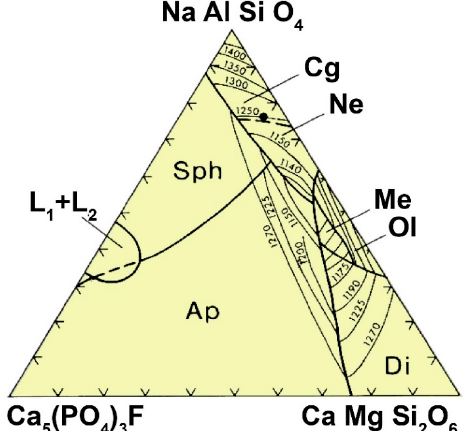
Figure 7. Phase relations in the system NaAlSiO 4 —CaMgSi 2 О 6 -Ca 5 (PO 4 ) 3 F at 1 atm. pressure [9]. С g— carnegieite, Ne—nepheline, Ol—olivine, Me—melilite, Di—diopside, Ap—apatite,